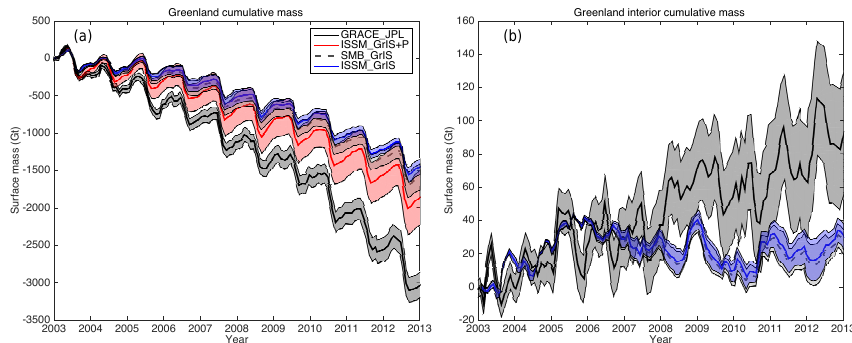
Figure 3. Cumulative mass from 2003 to 2012 for (a) all of Greenland and (b) the Greenland interior, comparing observations from GRACE (GRACE_JPL) with model output: mean of the model simulations of the Greenland Ice Sheet (ISSM_GrIS), ISSM_GrIS with mass from the periphery (ISSM_GrIS+P), and the mean of the SMB anomalies over the Greenland Ice Sheet (SMB_GrIS). For all time series, 1 σ uncertainties (see Sect. 5) are displayed. Note the differences in scale between the two figure